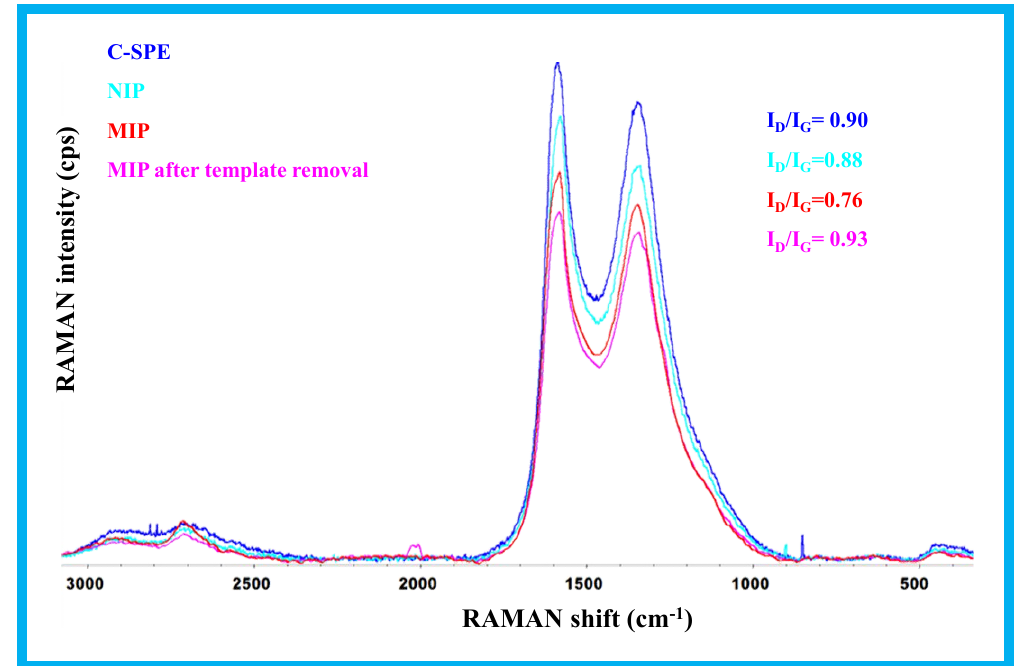
Figure 3. Raman spectra of C-SPE, MIP before and after template removal and NIP.